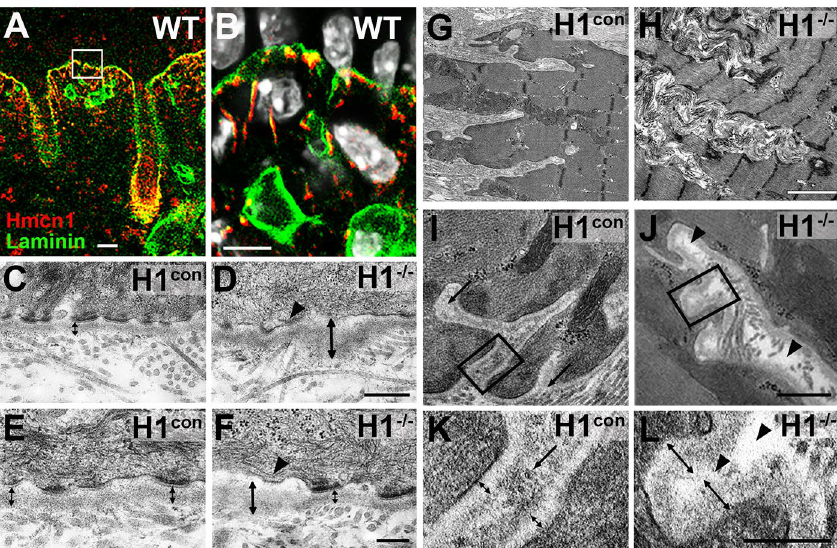
Figure 6. Ultrastructural changes in basement membranes and the organization of dermal-epidermal and myotendinous junctions of Hmcn1 mutants. ( A, B ) Co-immunolabeling visualized by confocal immunofluorescence microscopy shows partial co-localization of Hmcn1 with the BM marker laminin-α2 at epidermal-dermal junction of back skin; B shows magnified view of region boxed in A; nuclear DNA stained with DAPI (white). ( C – F ) TEM analysis of murine back skin revealed a thickening of the BM in absence of Hmcn1 ( D, F ) compared to wild-type siblings ( C, E ). Bidirectional arrows mark area occupied by lamina densa and lamina lucida of dermal-epidermal BM, arrowheads in D, F point to hemidesmosomes of compromised morphology. ( G, H ) TEM analysis shows abnormal tendinous interdigitation patterns and ECM deposition at the myotendinous junctions of Hmcn1 −/− mice (G) compared to wild-type siblings (H). ( I–L ) Similar to identified BM alteration at DEJ, the BM at MTJ of Hmcn1 −/− mice is thickened. Bidirectional arrows mark area occupied by lamina densa and lamina lucida. The tips of the tendon interdigitations of wild-type controls harbor collagen fibers (arrows in I , K ) adjacent to the MTJ BM, whereas the interdigitation tips of Hmcn1 −/− mice are largely devoid of collagen fibers (arrowheads in J , L ). K , L show magnified views of regions boxed in ( I , J ). Scale bars: A = 10 µm; B = 5 µm; C, D = 250 nm; E, F = 150 nm; G, H = 1.5 µm; I, J = 500 nm; K , L = 250 nm. H1 −/− , Hmcn1 −/− mutants; H1 con , sibling controls of Hmcn1 −/−